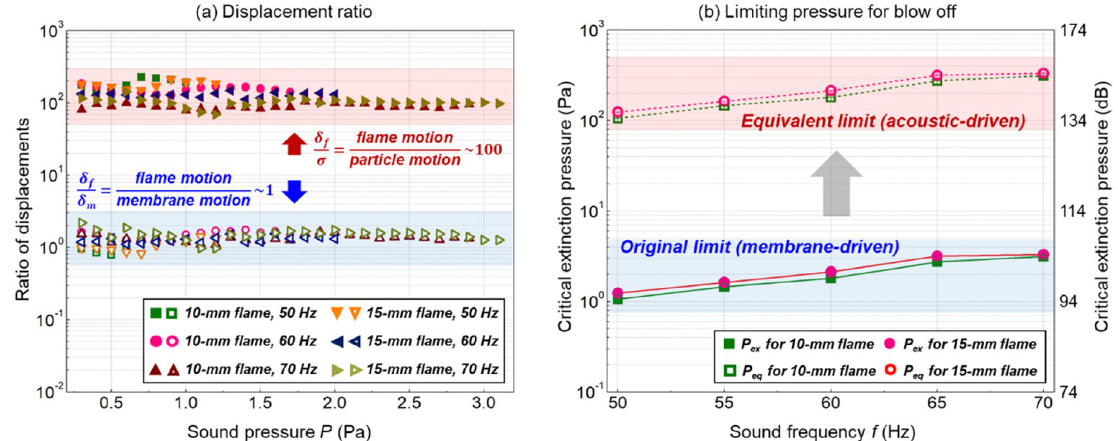
Figure 9. ( a ) Ratio of displacements, and ( b ) the original and equivalent extinction limits, where the conversion of sound pressure unit is dB = 20 • lg [ Pa /( 2 × 10 − 5 ) ]